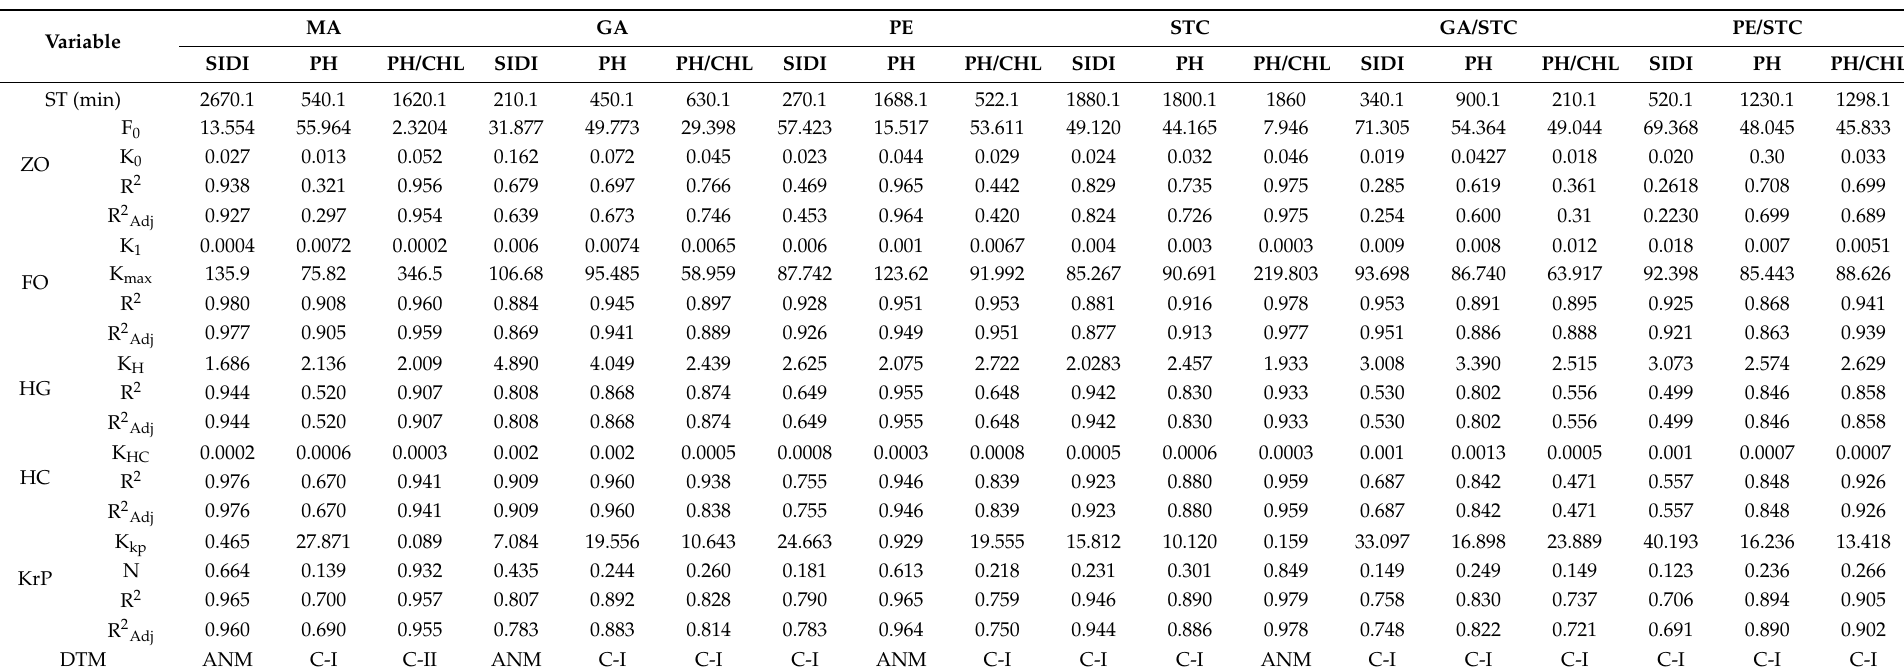
Table 5. In vitro release assays at pH